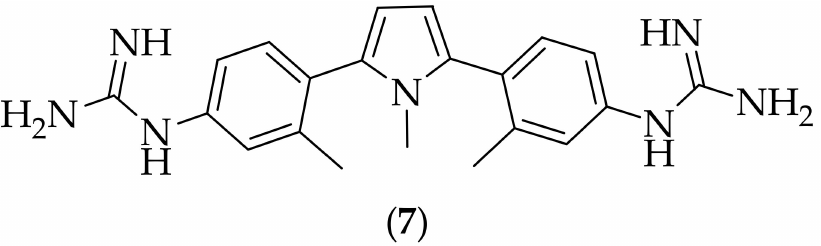
Figure 4. Pyrrole-diguanide antifungal derivative ( 7 ).